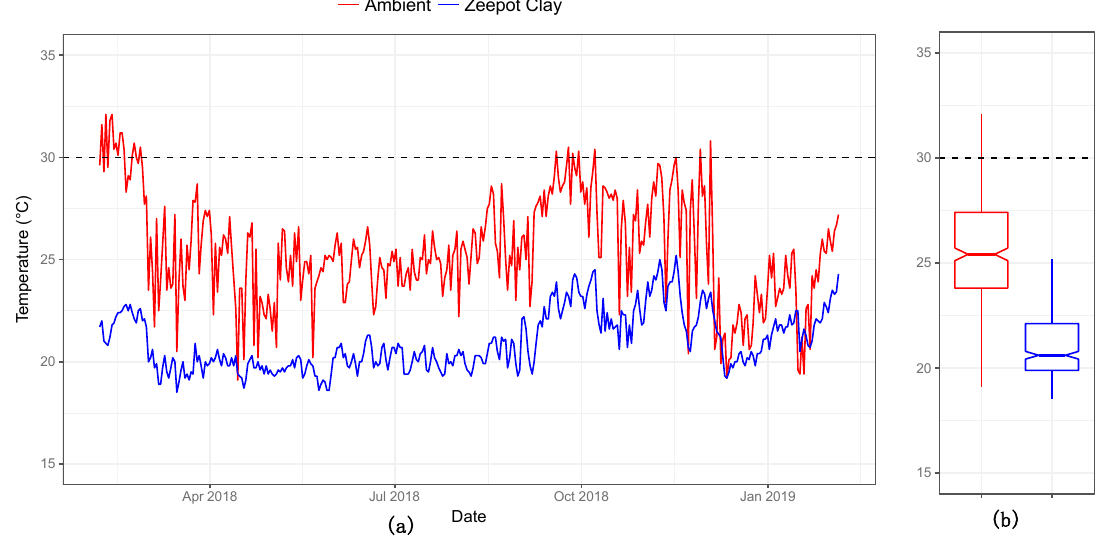
Figure 4. ( a ) Daily time series and ( b ) boxplot of ambient (red) and internal temperatures within the Zeepot Clay (blue) over the 12-month testing period in Bonchugu village, Serengeti district. The boxplot indicate median and range of temperatures whereas the dashed line shows maximum storage temperature above which the Nobivac TM Canine Rabies vaccine loses potency.